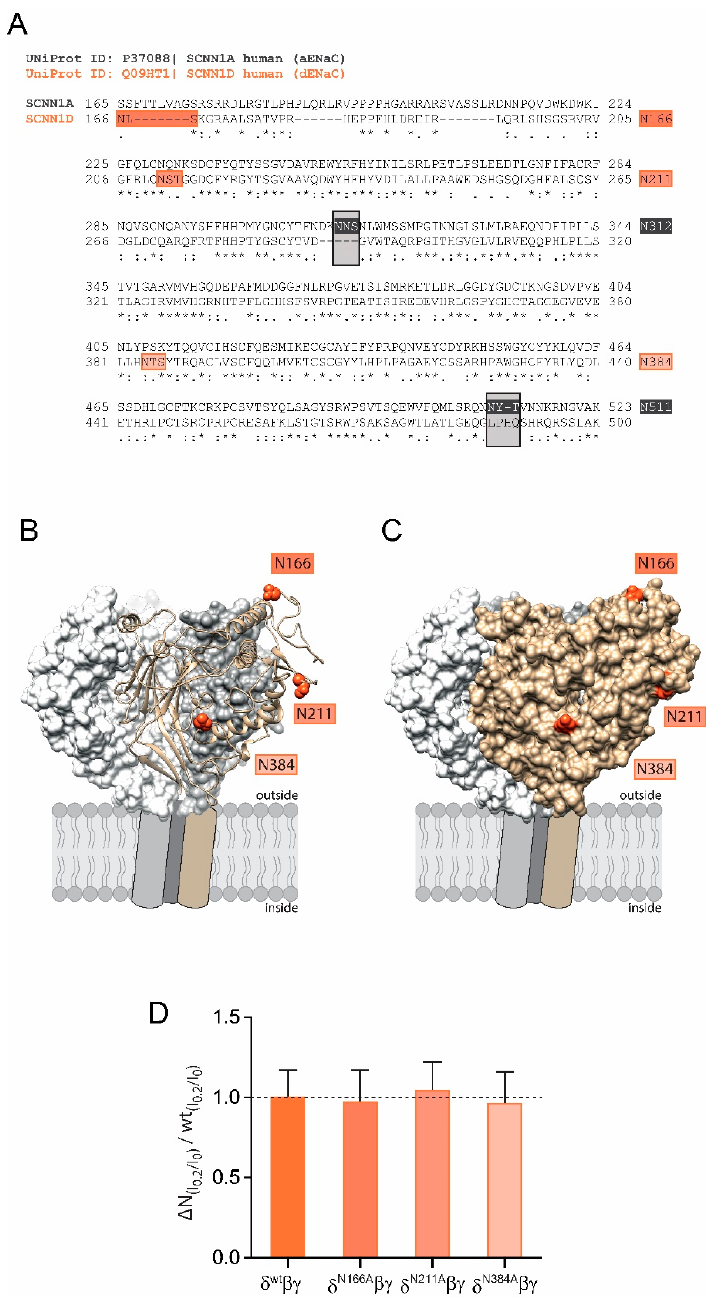
Figure 2. Shear force effect of δβγ ENaC is not mediated by intrinsic N-glycosylation sites. ( A ) Sequence alignment of the extracellular domains of human α (SCNN1A, grey) and δ (SCNN1D, orange) ENaC. N-glycosylation motifs of α ENaC that facilitate the shear force response are highlighted in black, whereas intrinsic N-glycosylation motifs of δ ENaC are coloured in orange. ( B ) Cartoon representation of the extracellular domain of human δ ENaC (highlighted in tan) together with wt β (grey) and γ subunit (white) that are shown as surface representation. The predicted localization of glycosylated asparagines 166, 211 and 384 within δ ENaC are highlighted as spheric molecules representation and coloured in orange. ( C ) Solvent accessible surface representation of δ ENaC indicates that the glycosylated asparagine residues are localised at exposed positions, likely to provide connections to the ECM. ( D ) Individual disruption of the three intrinsic N-glycosylation sites ( ∆ N) in δ ENaC did not affect the shear force response (I 0.2 /I 0 normalised for each construct) when compared with channels containing the wild type δ ENaC subunit (I 0.2 /I 0 of δ wt βγ = 1 indicated by the dashed line, unpaired t